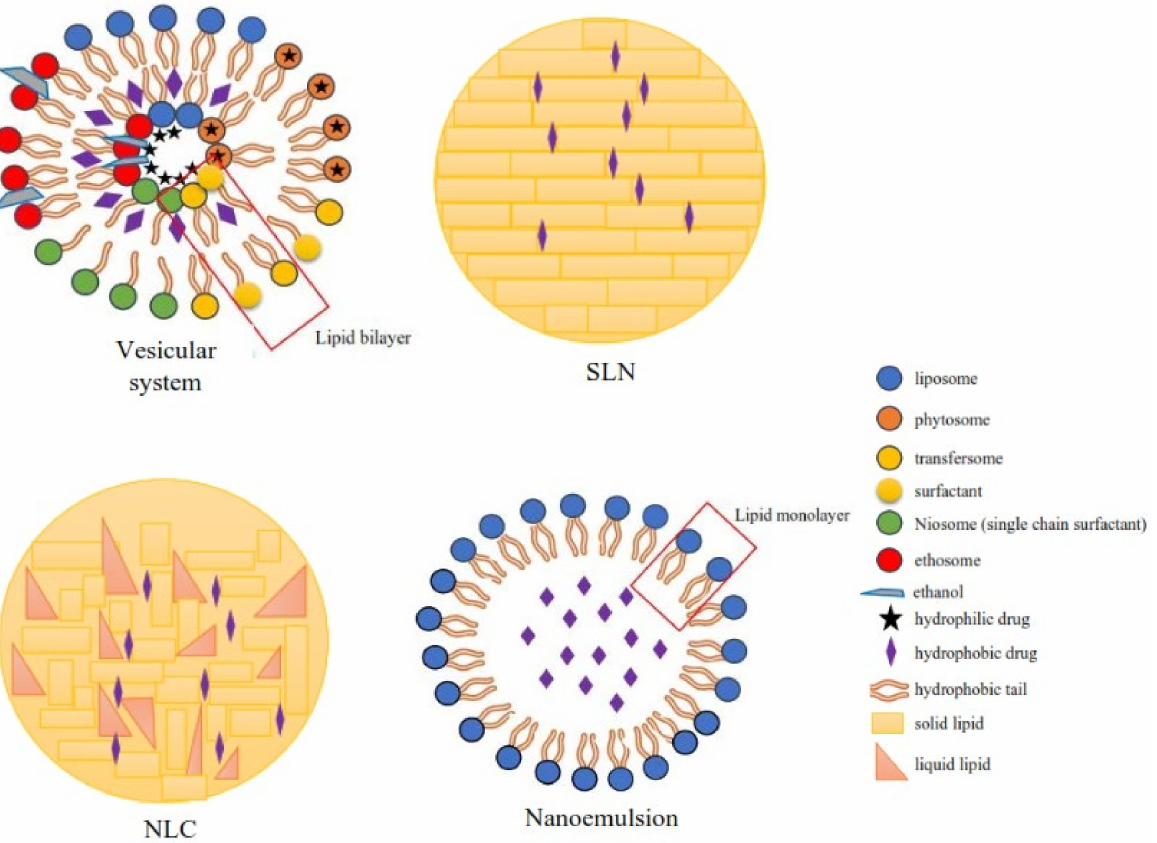
Figure 3. Classification of the lipid-based delivery